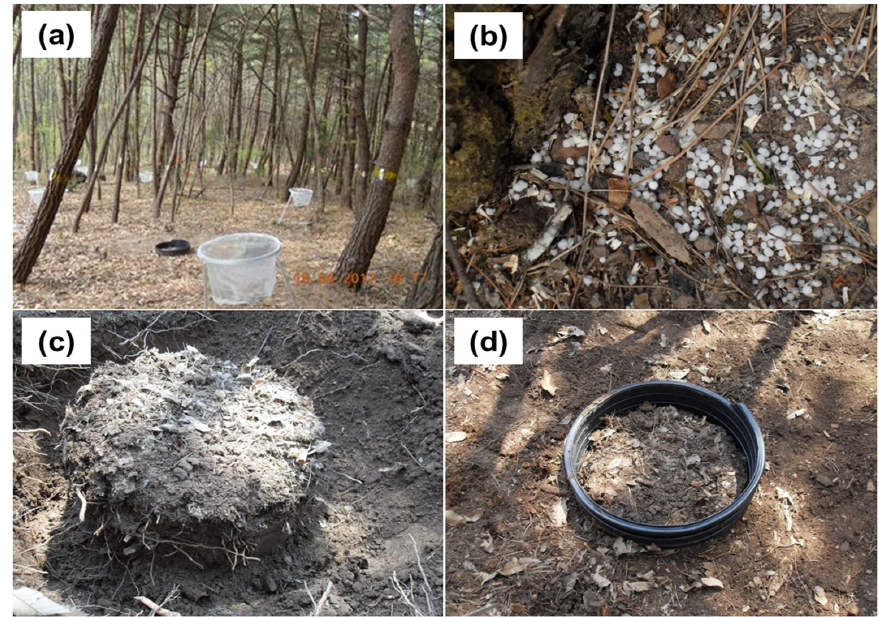
Figure 1. Study site ( a ), fertilizer application (( b ): white grains are urea) and trenching treatments ( c ) with polyvinyl chloride collars ( d ) to separate Rh rates from Rs rates.